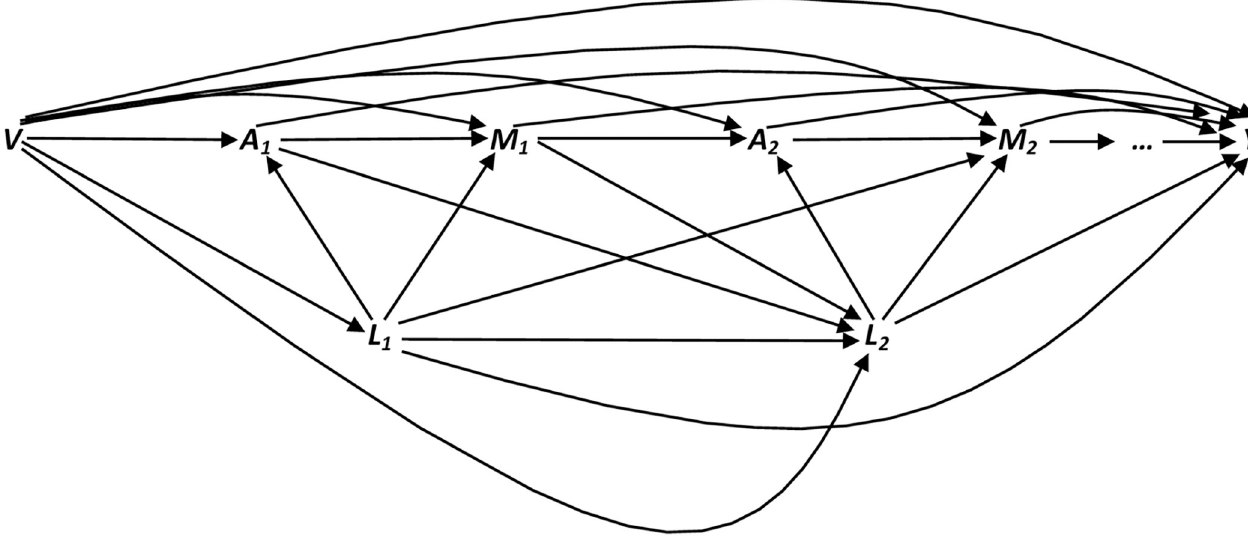
Fig 1. Causal diagram depicting the effect of time-varying exposure (smoking) on the outcome (CHD) in the presence of time-varying mediator (weight). V, A, M, L, and Y stand for baseline confounders, time-varying exposure, time-varying mediator, time-varying confounders, and the outcome,